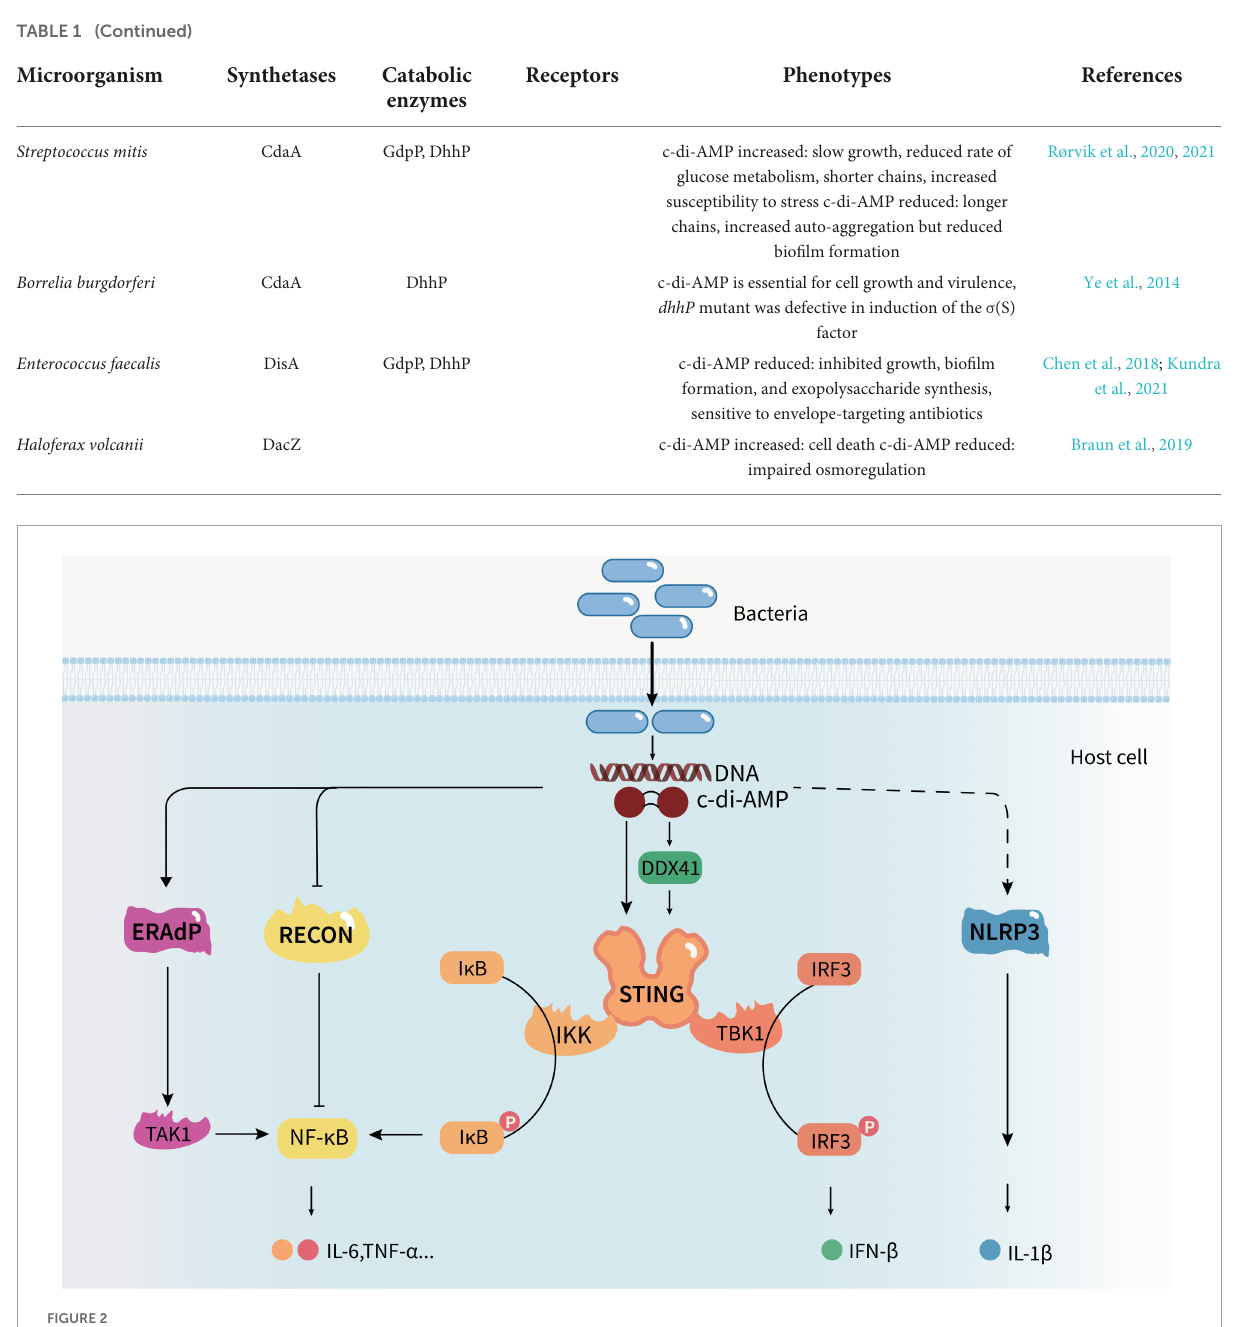
and spread of bacteria in the host. So far, four c-di-AMP sensors/receptors or adaptors have been found in eukaryotic cells: stimulator of interferon genes (STING) (Aliakbar Tehrani et al., 2021); RNA helicase DDX41 (D-E-A-D